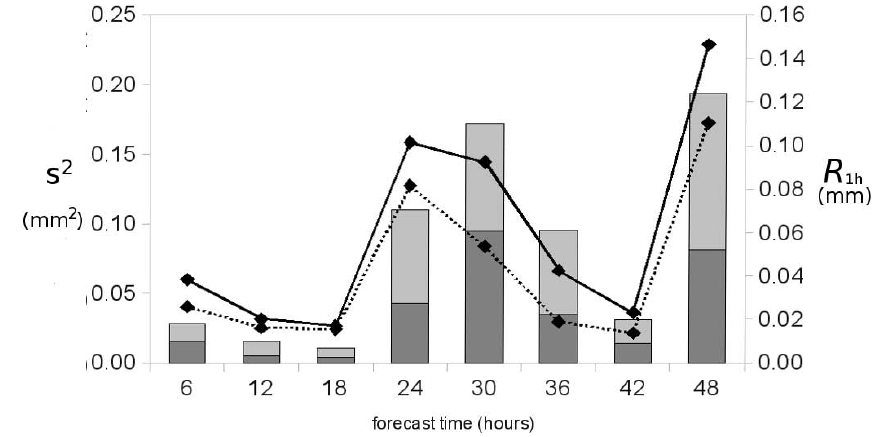
Fig. 6. As for Fig. 5 but after smoothing the precipitation field (see